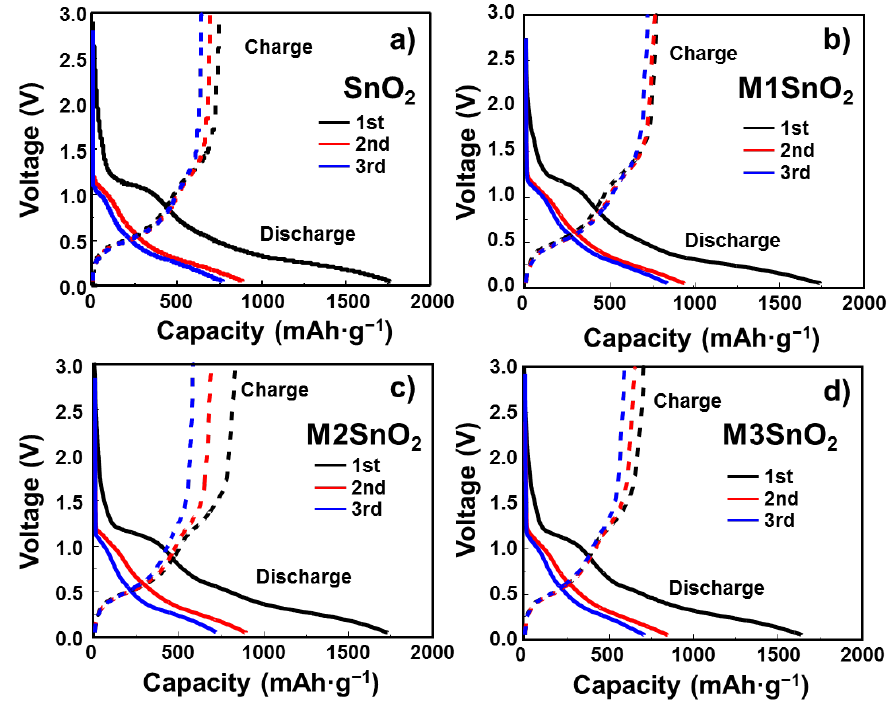
Figure 6. Galvanostatic charge–discharge profiles of ( a ) SnO 2 NS and ( b – d ) M1 / M2 / M3SnO 2 anodes for the initial three cycles.